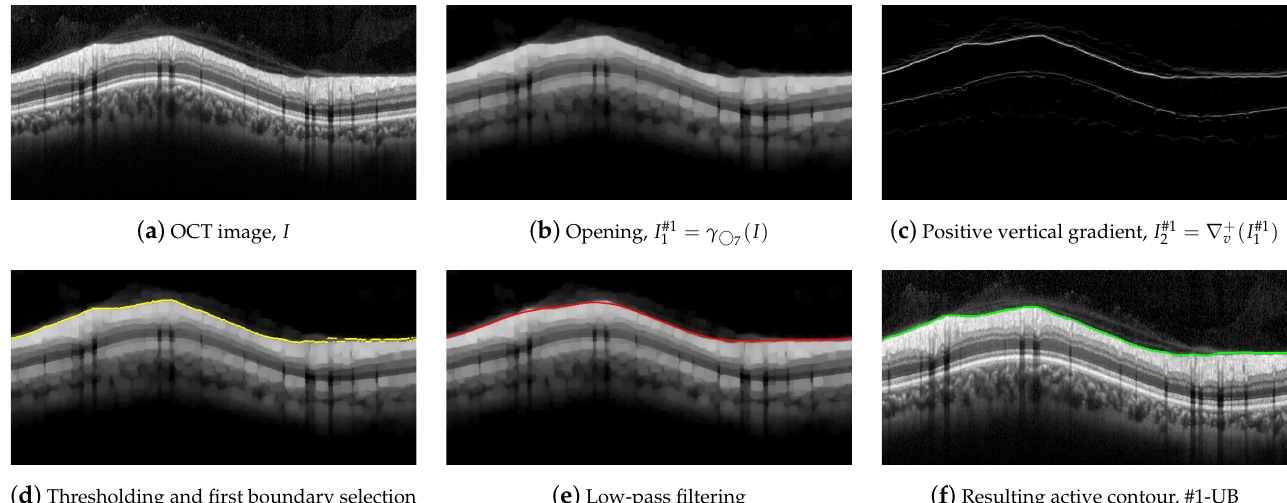
Figure 7. Steps for the delineation of the